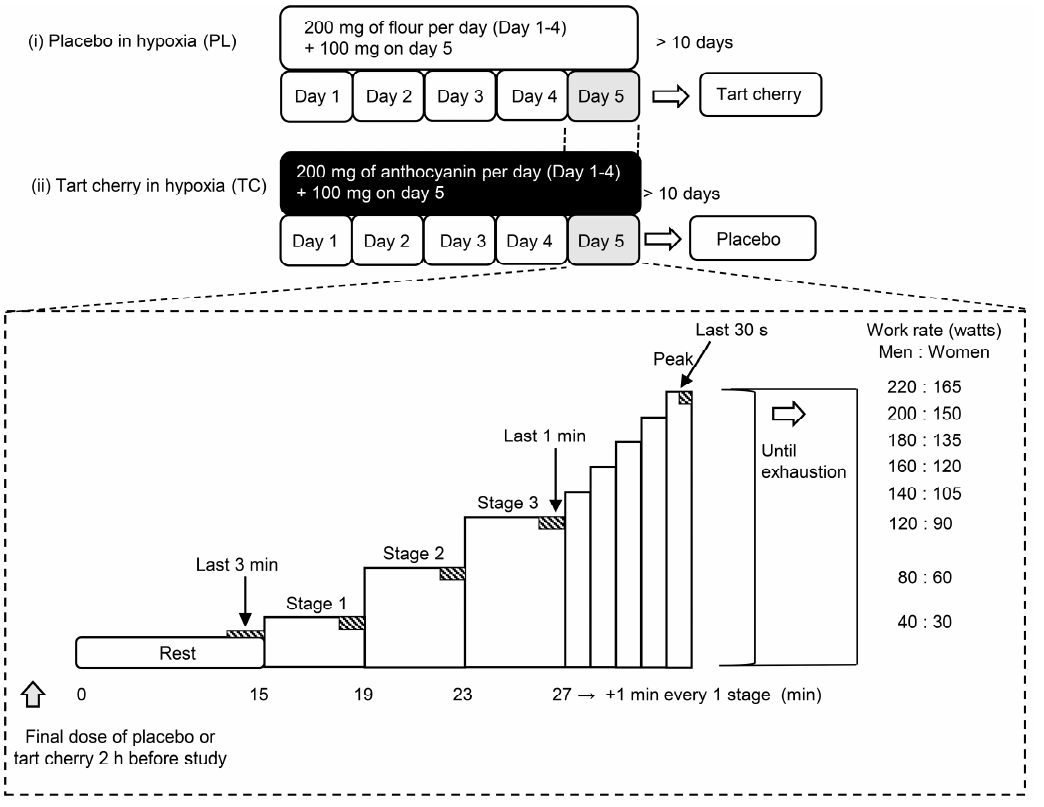
Figure 1. Study protocol of the present study. PC; placebo, TC; tart cherry. Rectangles with diagonal lines indicate the cardiorespiratory and near-infrared spectroscopy measurement period.